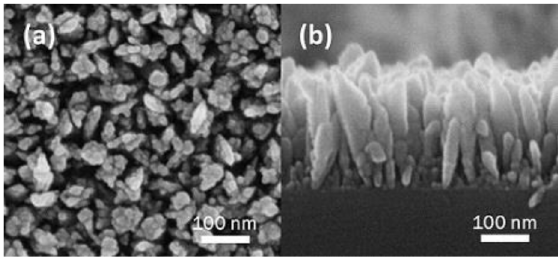
Fig. 2. FESEM images of the optimized TiO 2 thin fi lm on a silicon wafer, (a) top view and (b) cross-section.